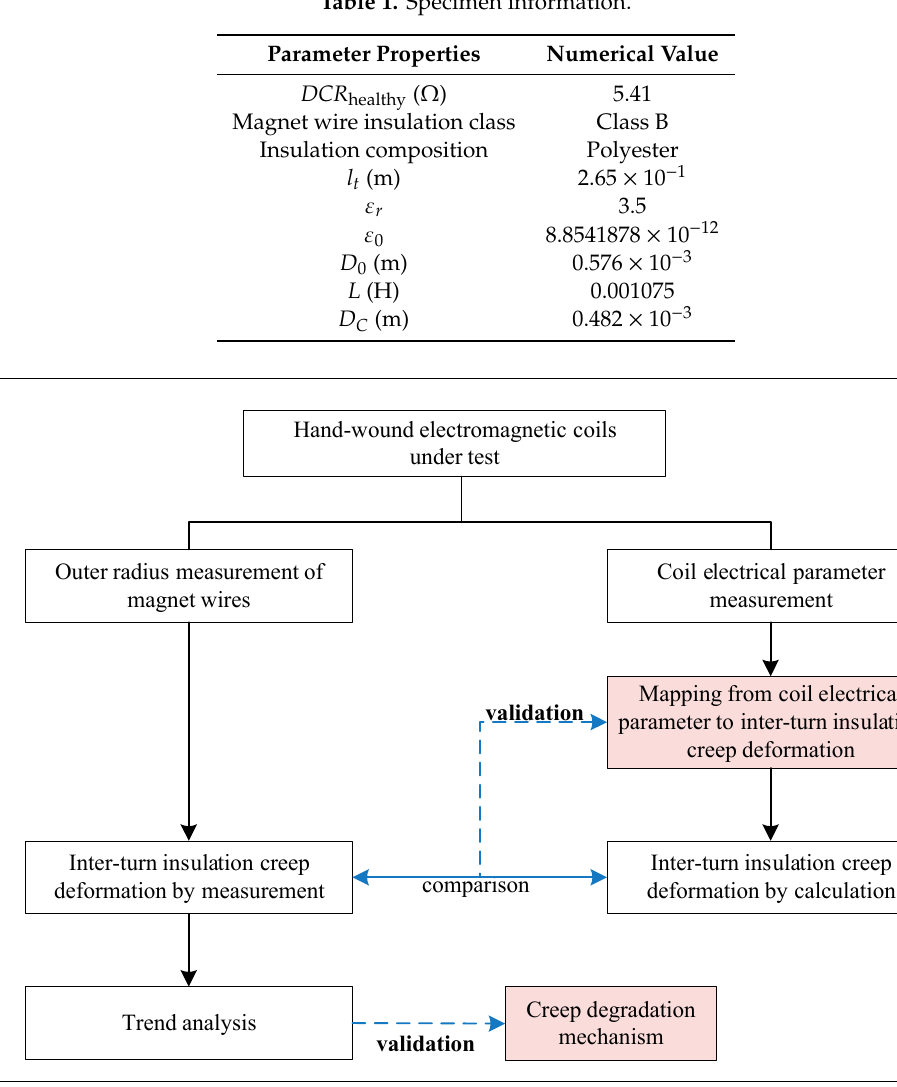
Figure 9. Illustration of the experimental process.